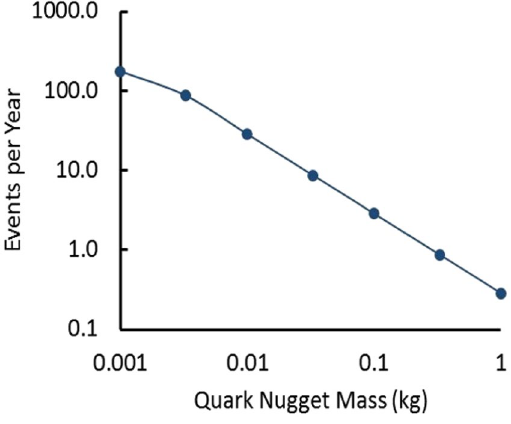
Figure 10. Estimated number of events per year near the indicated